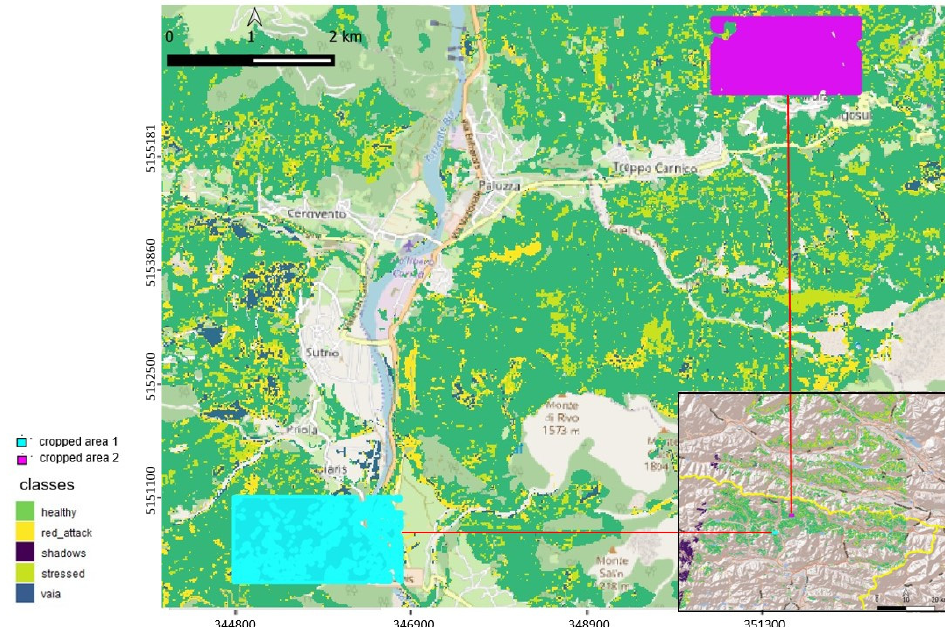
Figure 8. Location of two cropped areas in the study area selected to visualise classification results and changes in forest cover and health based on classes of healthy forest stands, stressed vegetation, stands in the bark beetle “red-attack” stage and Vaia-storm-related windthrows (OpenStreetMap base map). Reference System: WGS84-UTM33N. Forest stands in cropped area nr. 1 already showed conditions of stress and the “red_attack” stage in June 2017 (Figure 9A). The sites detected as stressed in June 2017 (Figure 9A) were classified as “red_attack” stage stands in the classification map of July 2018 (Figure 9B). The area was already suffering from bark beetle infestations before the Vaia storm occurred. However, a significant increase in damage can be seen in the “after Vaia” situation in 2019 and 2020, especially beginning in September 2019 (Figure 9E) and July 2020 (Figure 9F). Some of the stands that were already stressed in May 2019 (Figure 9C) changed into the “red_attack” stage in July 2019 (Figure 9D), and others changed in September 2019 (Figure 9E). Not all of the stands detected as stressed turned into the “red_attack” stage, but all of those which eventually turned out to have been infested by bark beetles had previously been classified as stressed. The bark beetle spread that oc- curred after the Vaia storm progressed along forest edges and/or in proximity to wind- felled patches (Figure 9D–F). At the same time, according to the classification results (Fig- ure 9), forest stands that suffered damage from Vaia were located along forest edges and/or next to forest stands that were already suffering from bark beetle infestations be- fore the storm occurred.